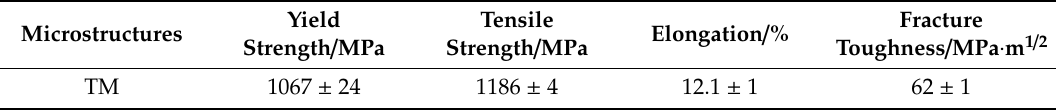
Table 1. The mechanical properties of the bimodal microstructure and bi-lamellar microstructure.